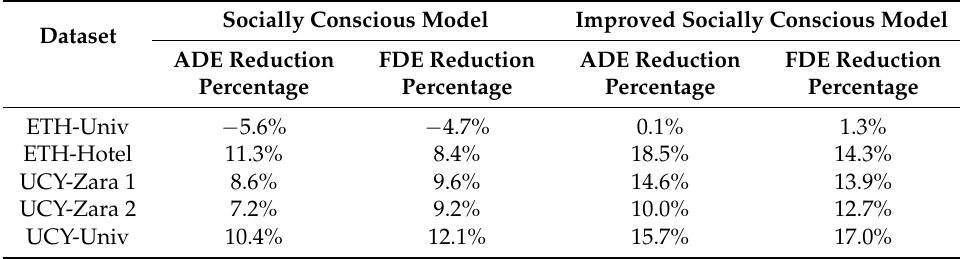
Table 2. Prediction error reduction